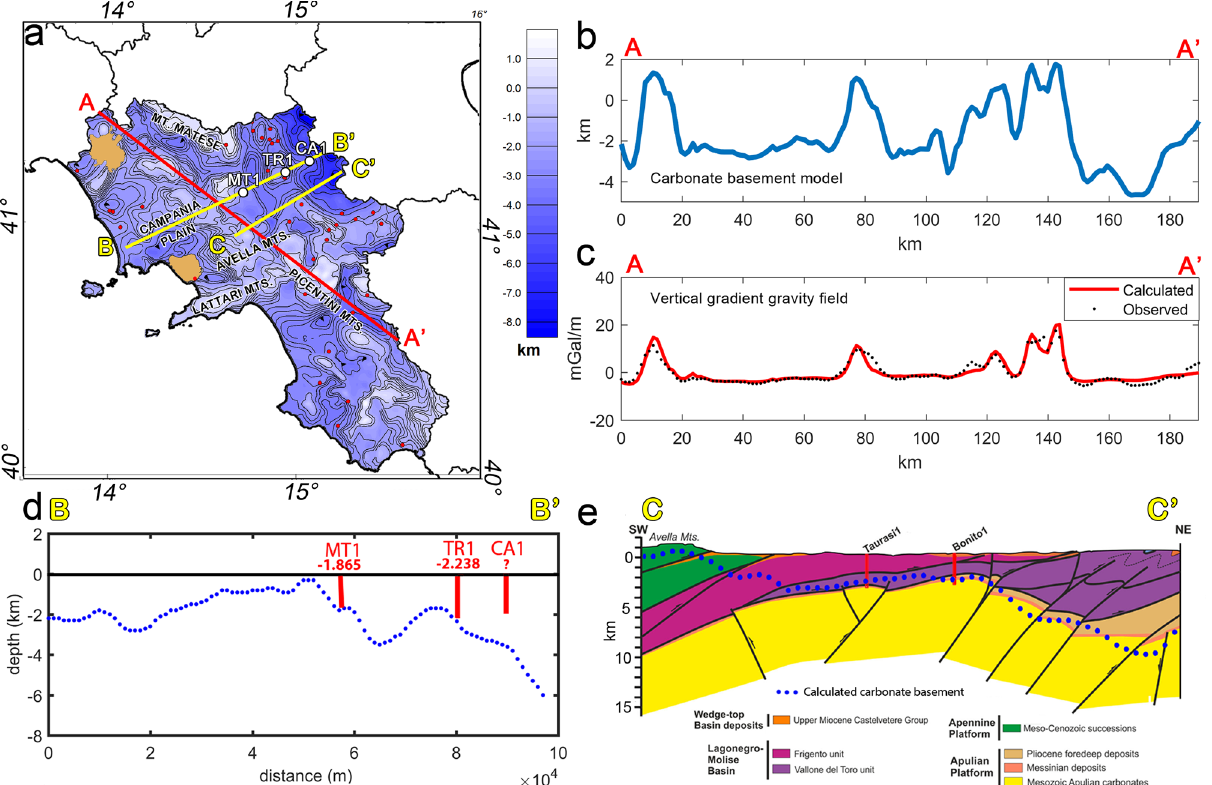
Figure 8. ( a ) Map of the carbonate basement with the plot of the selected profiles; ( b ) Morphology of the inferred carbonate basement model along the profile A-A ′ ; ( c ) Fit of the vertical gradient calculated from the carbonate surface with the vertical gradient of the observed Free-air gravity field; ( d ) Comparison between the inferred carbonate model and the wells along the profile B-B ′ . MT1: MonteTaburno1 well; TR1: Tranfaglia1 well; CA1: Casalbore1 well. ( e ) Geological cross-section along the profile C–C ′ (modified after 36 ). The depths to the carbonate basement top estimated by gravity data inversion are drawn along the same profile (blue